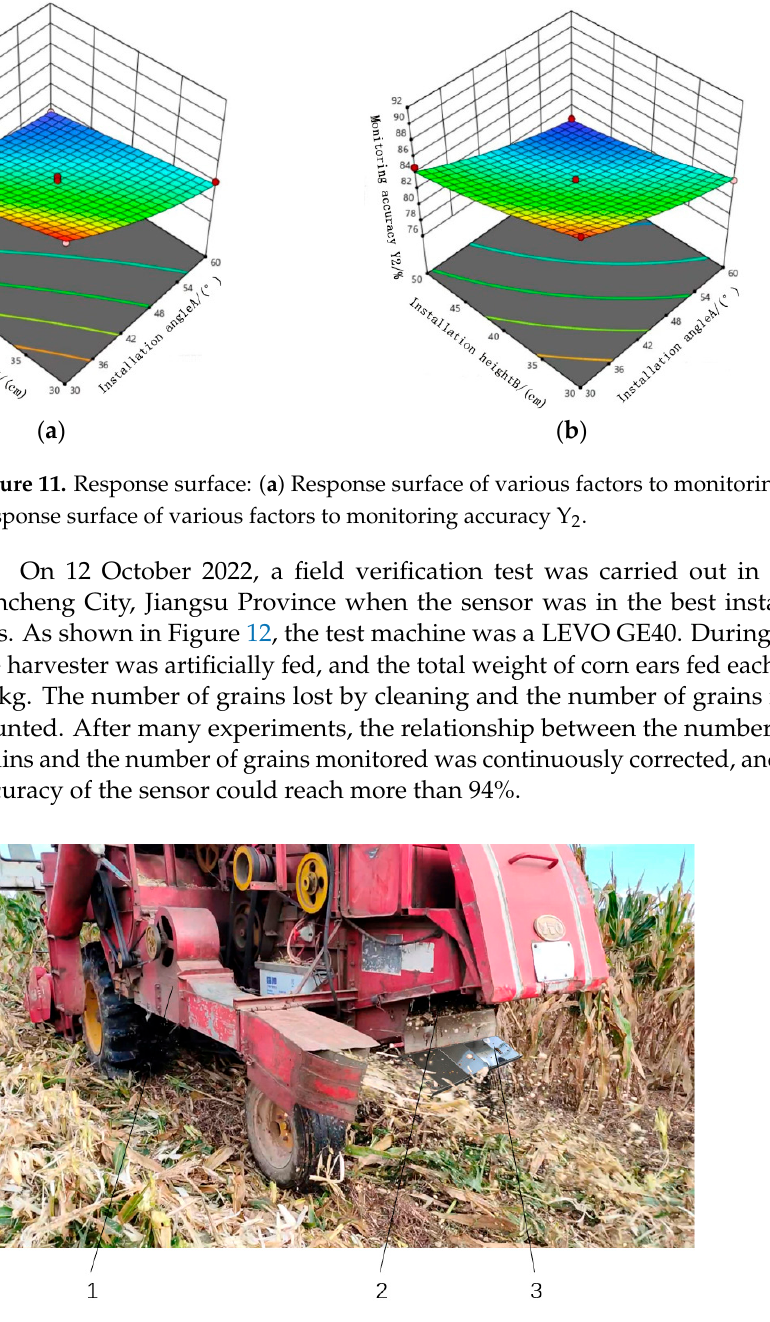
Figure 12. Field test: 1—LEVO GE40 harvester; 2—Cleaning miscellaneous mouth; 3—Loss monitoring sensor.